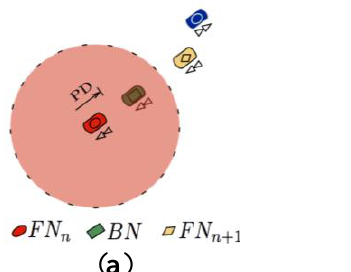
Figure 2. Example of the redundancy strategy implemented in FPBR. ( a ) The discovery packet reaches